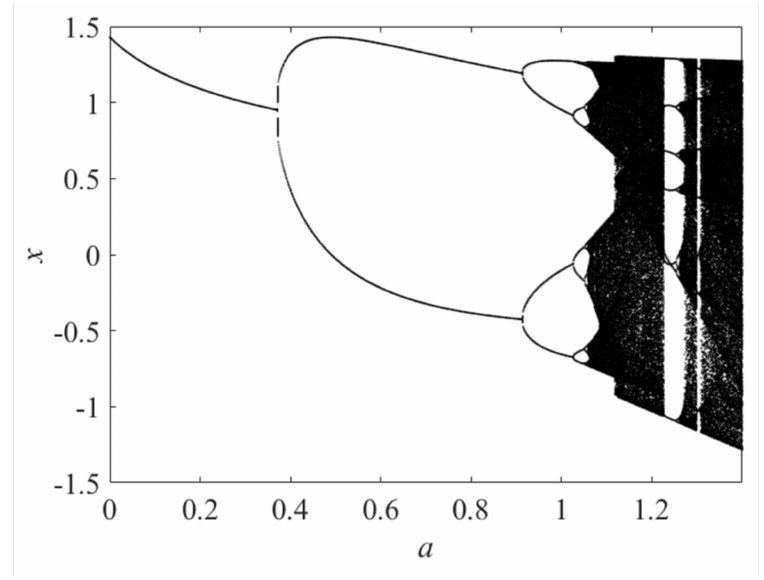
Figure 2. Bifurcation diagram of Henon chaotic map.